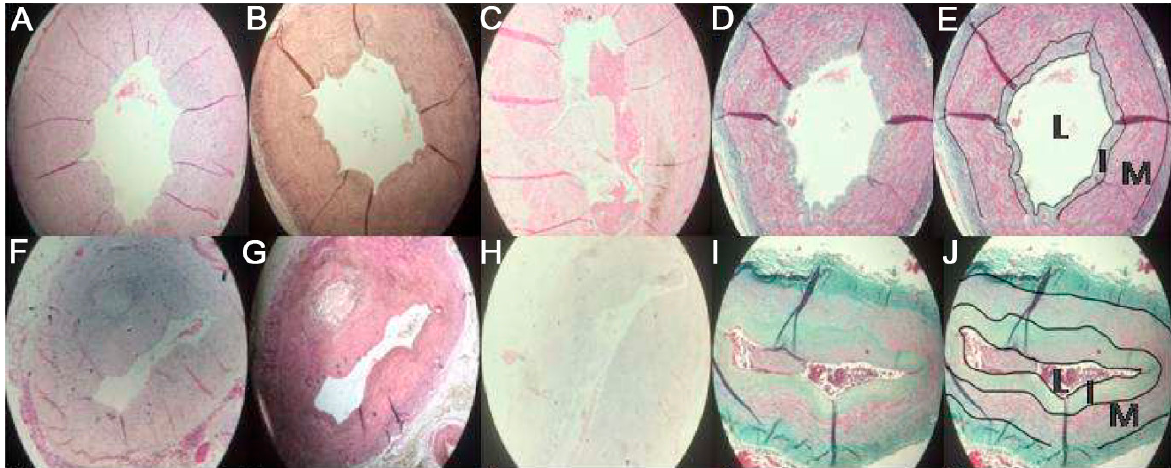
Figure 2. Histology and morphometric analysis of the radial artery samples. The upper panel represents the control group, and the lower panel represents patients. Hematoxylin ( A , F ), Verhoff’s elastic ( B , G ), Von Kossa ( C , H ) and GT staining ( D , I ) of the radial artery wall controls and patients, respectively. Morphometric analysis on GT staining ( E , J ) of controls and patients, respectively, showing luminal ( L ), intimal ( I ), and medial ( M ) areas.